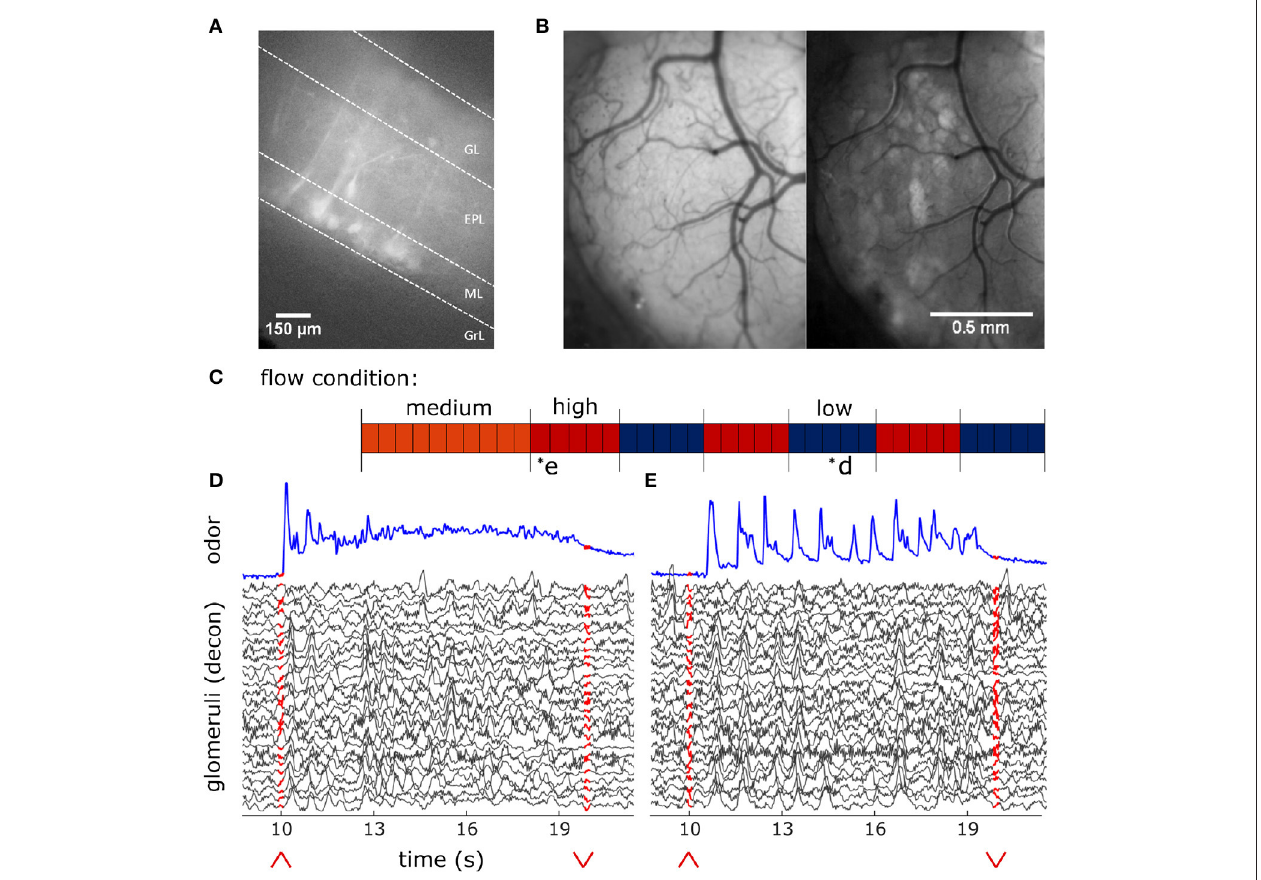
FIGURE 2 | In-vivo recording of glomerular population response. (A) Change in fluorescence of MT cells in an acute in vitro OB slice preparation averaged over 3 s following a puff of high K+ solution. (B) In vivo view of the dorsal olfactory bulb through an implanted cranial window. (Left) Window activity averaged across a single trial. (Right) Projected standard deviation for the same trial shows MT activity in the dorsal OB responsive to the odor presentation. (C) Diagram depicting flow conditions (high, medium, or low) of the 40 trials within a single session. (D) The deconvolved ethanol trace (blue) compared to the deconvolved response of each glomeruli (black) within the recorded FOV during a single low flow trial depicted by asterisk in (C) . Red arrows indicate onset and offset of plume presentation. (E) Same as (D) but for a single high flow trial from the same session also depicted by asterisk in (C)